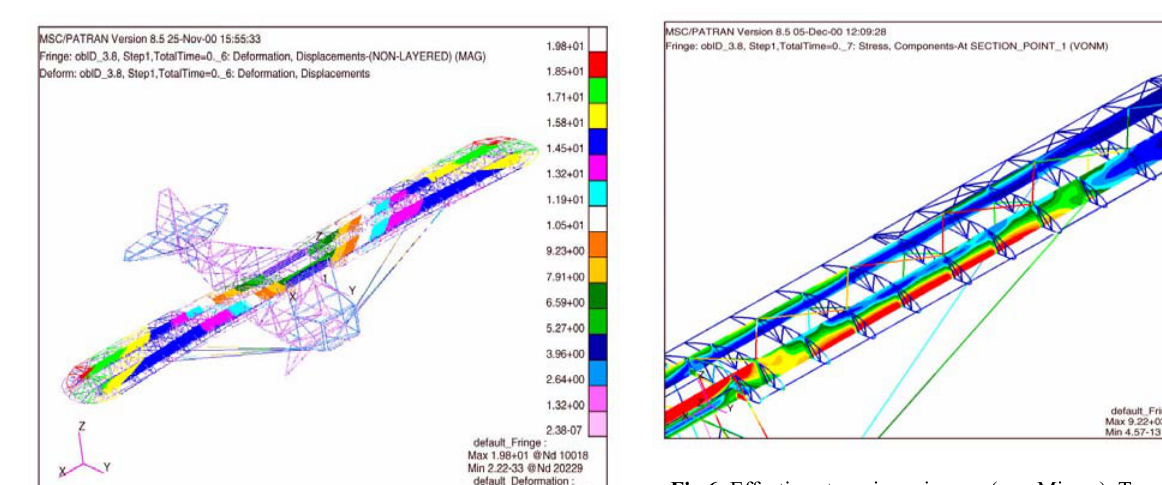
Fig 6. Effective stress in main spar (von Misses). Tension of bottom strips at level of 350[MPa]